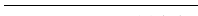
Figure 3. CRNS transect at Trail Valley Creek during the 2016/2017 and 2017/2018 field seasons. (a) Site transect during winter sam- pling. (b) Site during snow-free conditions; this image displays the tall alder shrub vegetation (green) and tundra vegetation (orange).